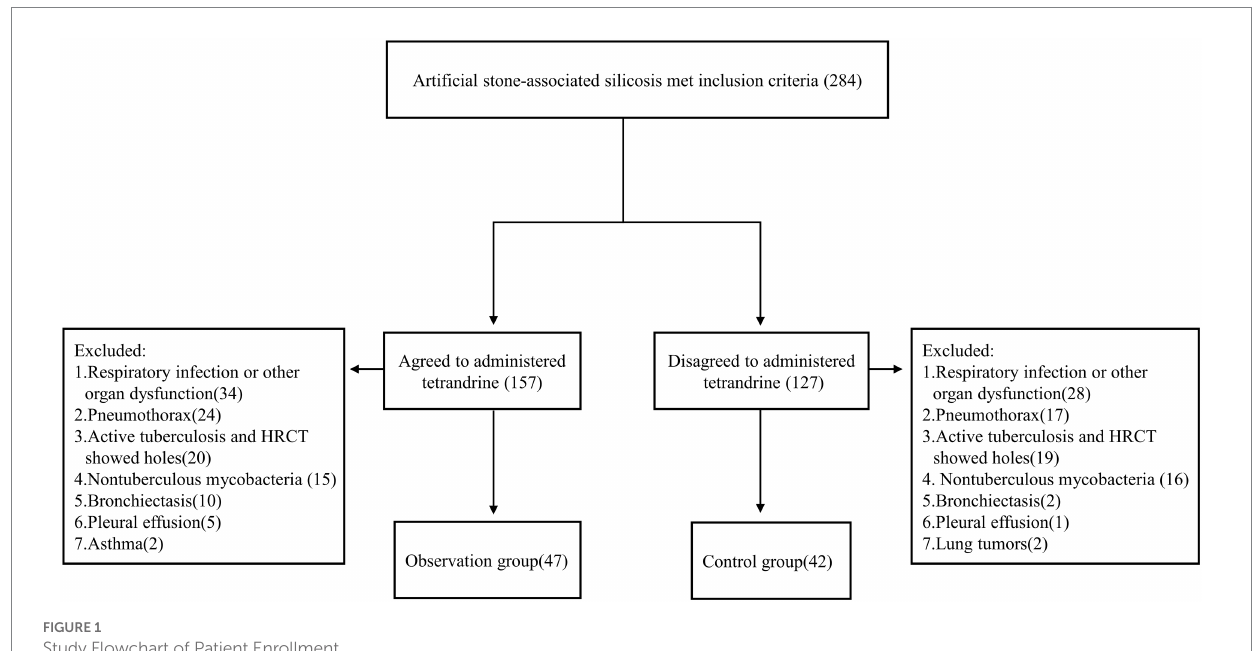
FIGURE 1 Study Flowchart of Patient Enrollment.